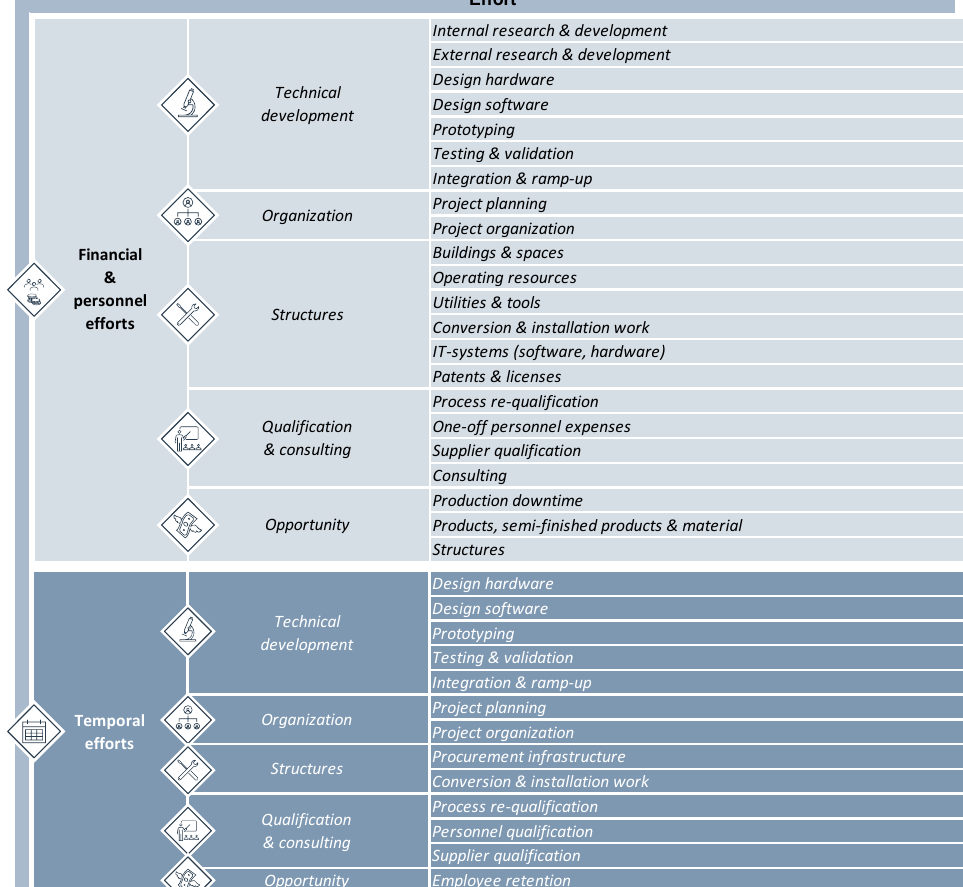
Figure 6. Relevant criteria to assess the risks of innovation projects in manufacturing.